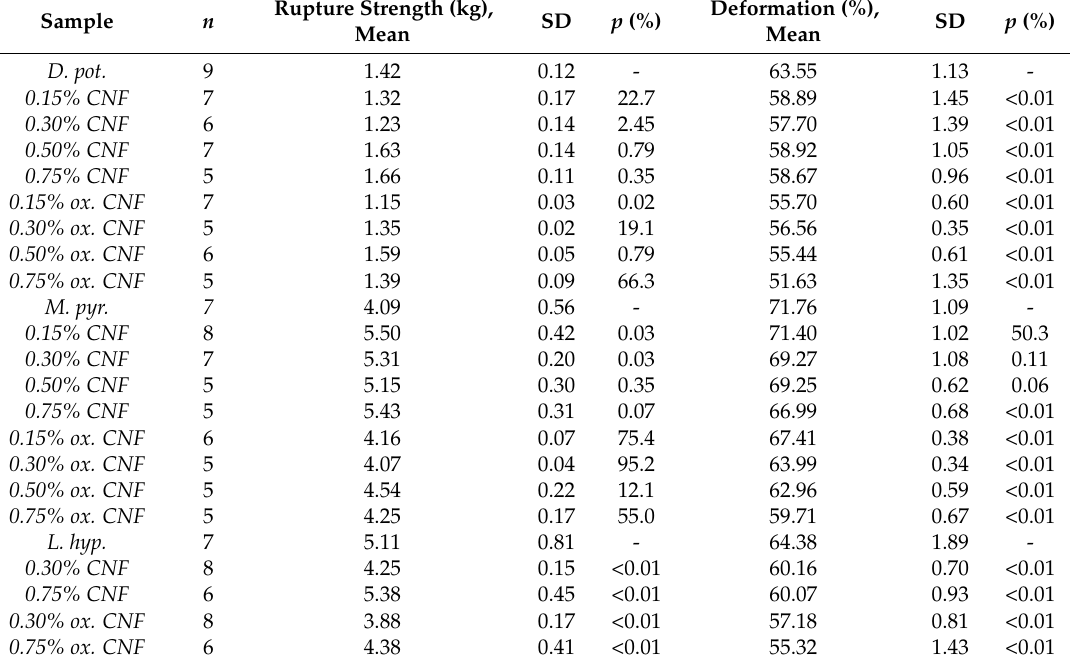
Table A4. Statistical outcomes, Figure 2: Rupture strength (mean), deformation (mean) standard deviation (SD), number of samples ( n ), and p -value ( p ) of samples compared to the respective pure alginate sample.